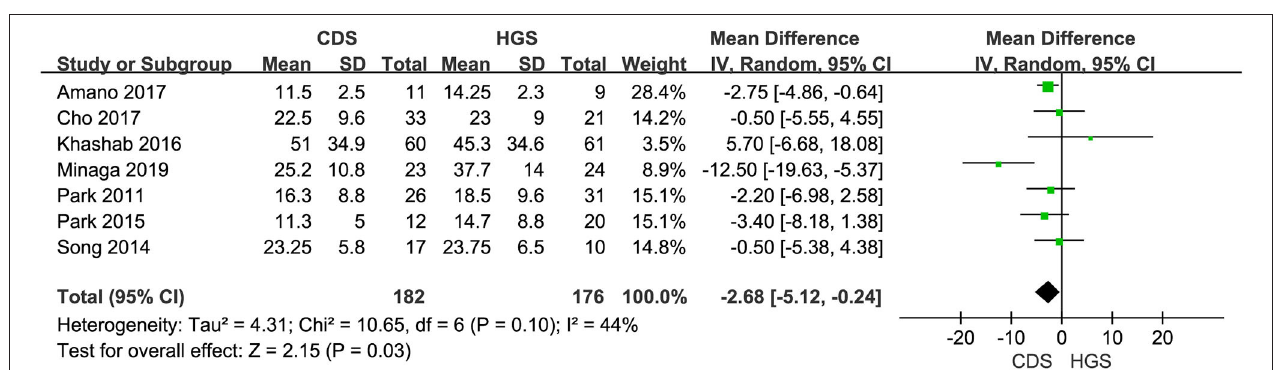
FIGURE 6 | Forest plot of procedure time between EUS-CDS and